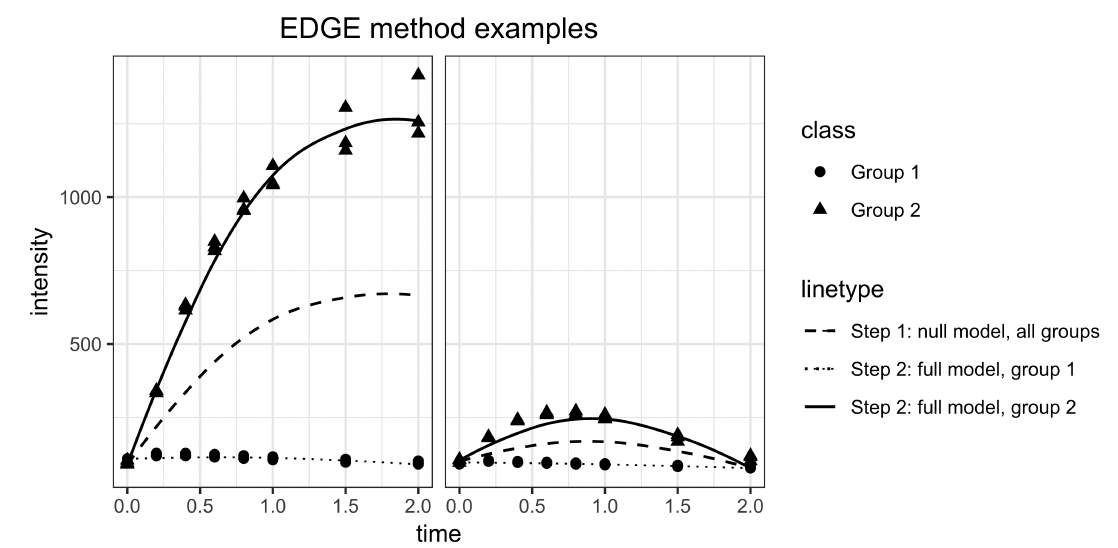
Figure 3. Illustration of the two steps in the EDGE algorithm for two different features ( left , right ). Step 1: The null hypothesis states that there is no difference between the groups. A single cubic spline curve is fitted to all data (dashed line). Step 2: In the alternative hypothesis, a curve is fitted to each group separately (dotted and full line). The improvement in goodness of fit is a measure for the difference between the